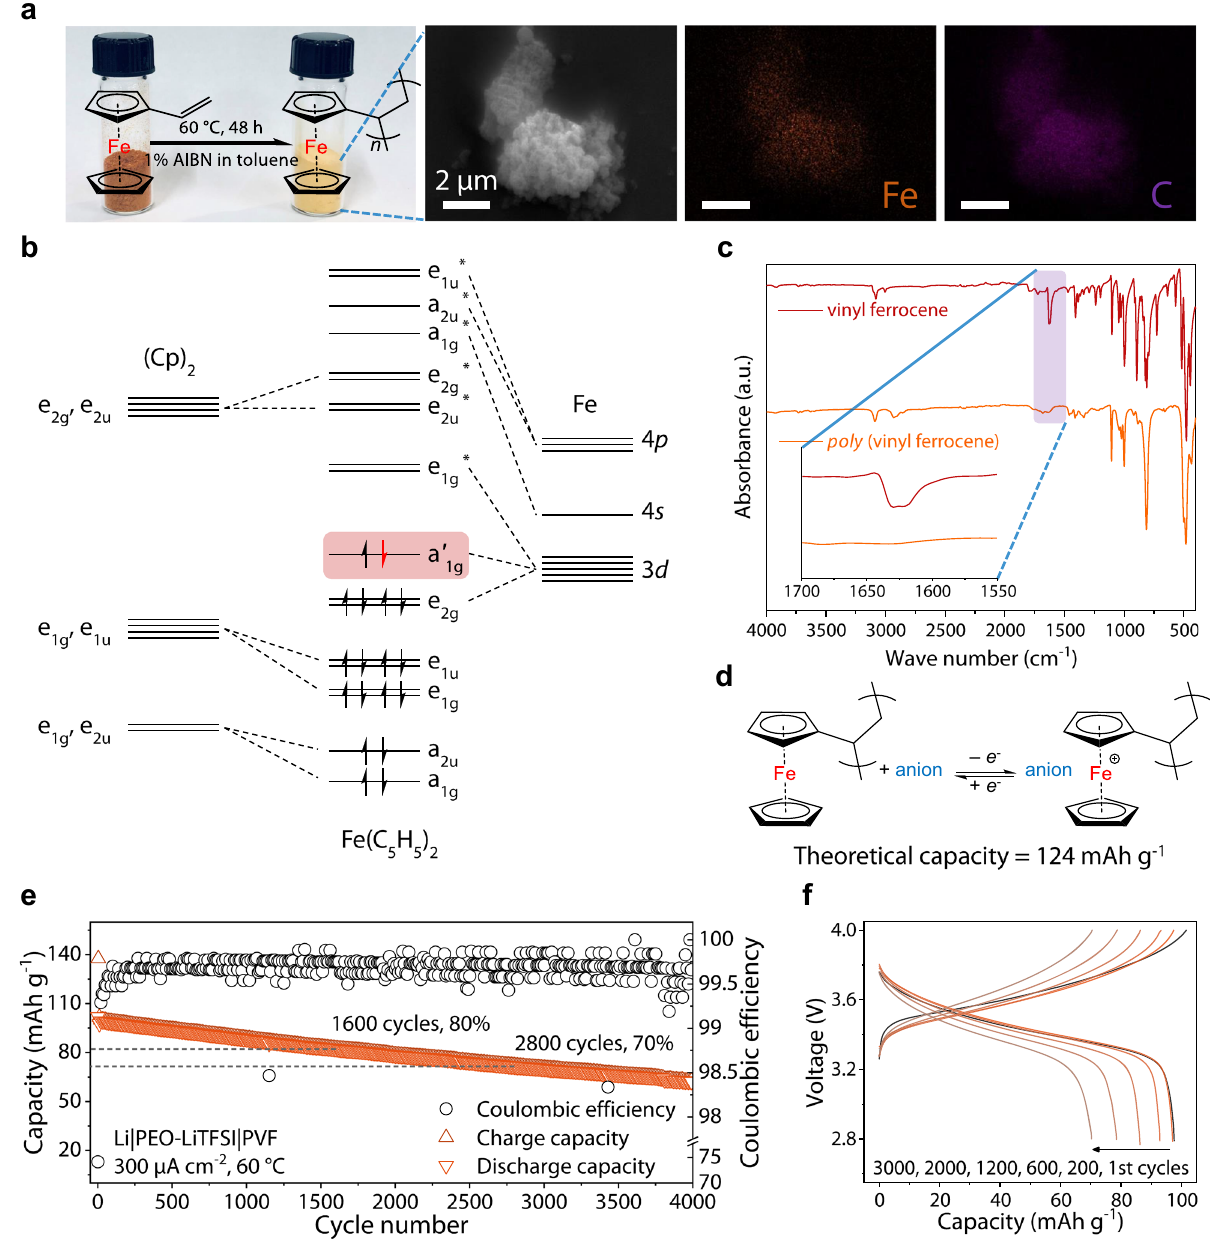
Fig. 2 Synthesis, physicochemical and electrochemical characterization of the polyvinyl ferrocene. a The optical image, SEM image and EDX elemental mapping results of the polyvinyl ferrocene. b The frontier orbital electronic structure of ferrocene/ferrocenium, while the electron transfer in the redox reaction ismarked in red. c FT-IRspectroscopy of vinyl ferroceneand polyvinyl ferrocene, the inset shows theweakening ofthepeakintensityat1625 cm − 1 . d The redox reaction of polyvinyl ferrocene with anions in electrolyte. The theoretical capacity is based on the molecular weight of the active unit and the charge transfers numbers. e , f show the capacity retention and charge-discharge curves of Li||PVF cell at 60°C, 300 μ A cm − 2 , respectively. The cell was cycled at 50 μ A cm − 2 in the fi rst 5 (Supplementary Table 1) prove that PVF has a high molecular weight (~4800 g mol − 1 ) with wide distribution (weight-average molecular weight/number-average molecular weight, M w / M n = 1.71). The redox activity of PVF can provide a theoretical capacity of 124 mAh g − 1 (Fig. 2d), located at the top level of the p-type organic cathode 41 . Moreover, the theoretical redox potential of ~3.45 V vs. Li + /Li can be tolerated by most SPEs. The thermo- gravimetric analysis (TGA) in Supplementary Fig. 1 shows that PVF did not undergo signi fi cant thermal weight loss or phase change below 300 °C, ensuring the electrode stability in the case of high